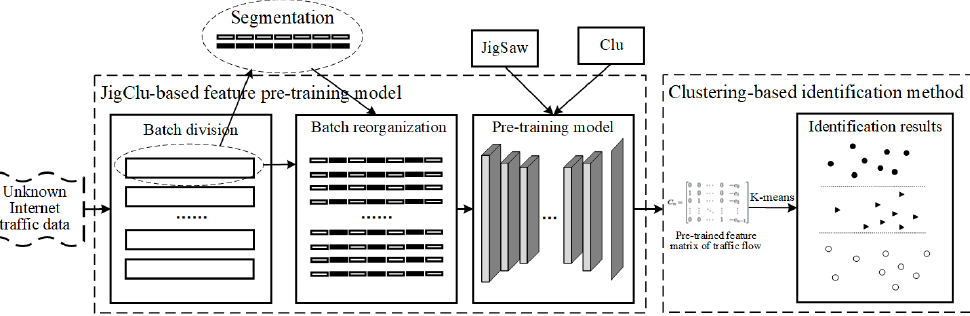
Figure 3. The self-supervised learning-based identification model for unknown Internet